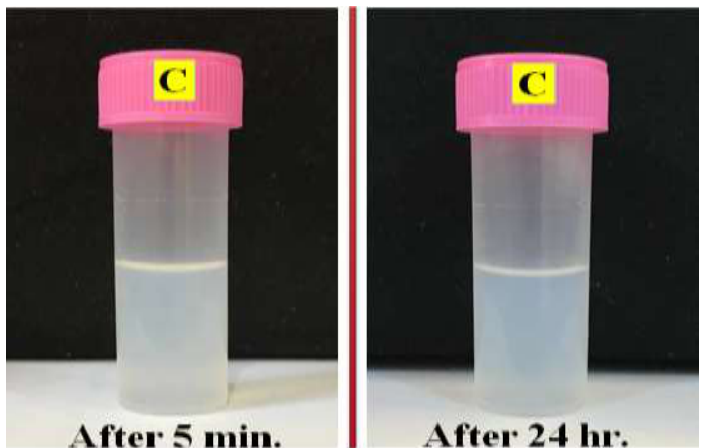
Figure 4: The high stability of the RES-loaded poloxamer 407 after 24 hr of preparation. [(C) RES-loaded poloxamer